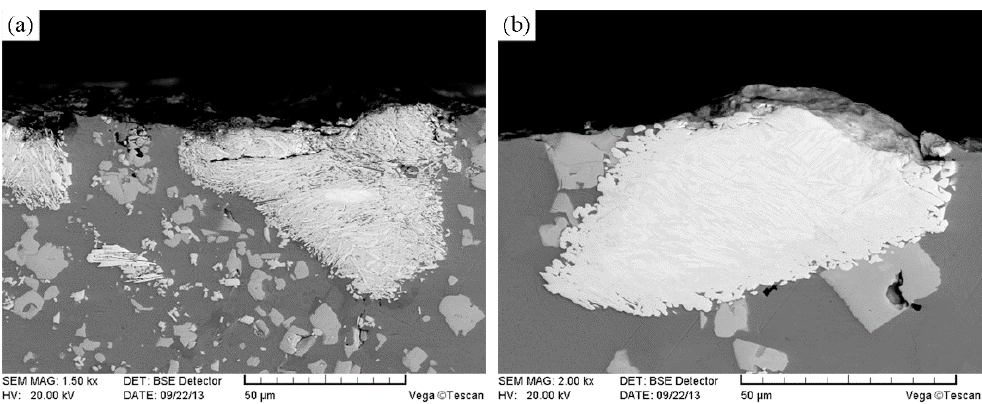
Figure 17. Cross-sections morphologies of ( a ) the unmodified, and ( b ) the modified CTC P -NiCrBSi at RT.